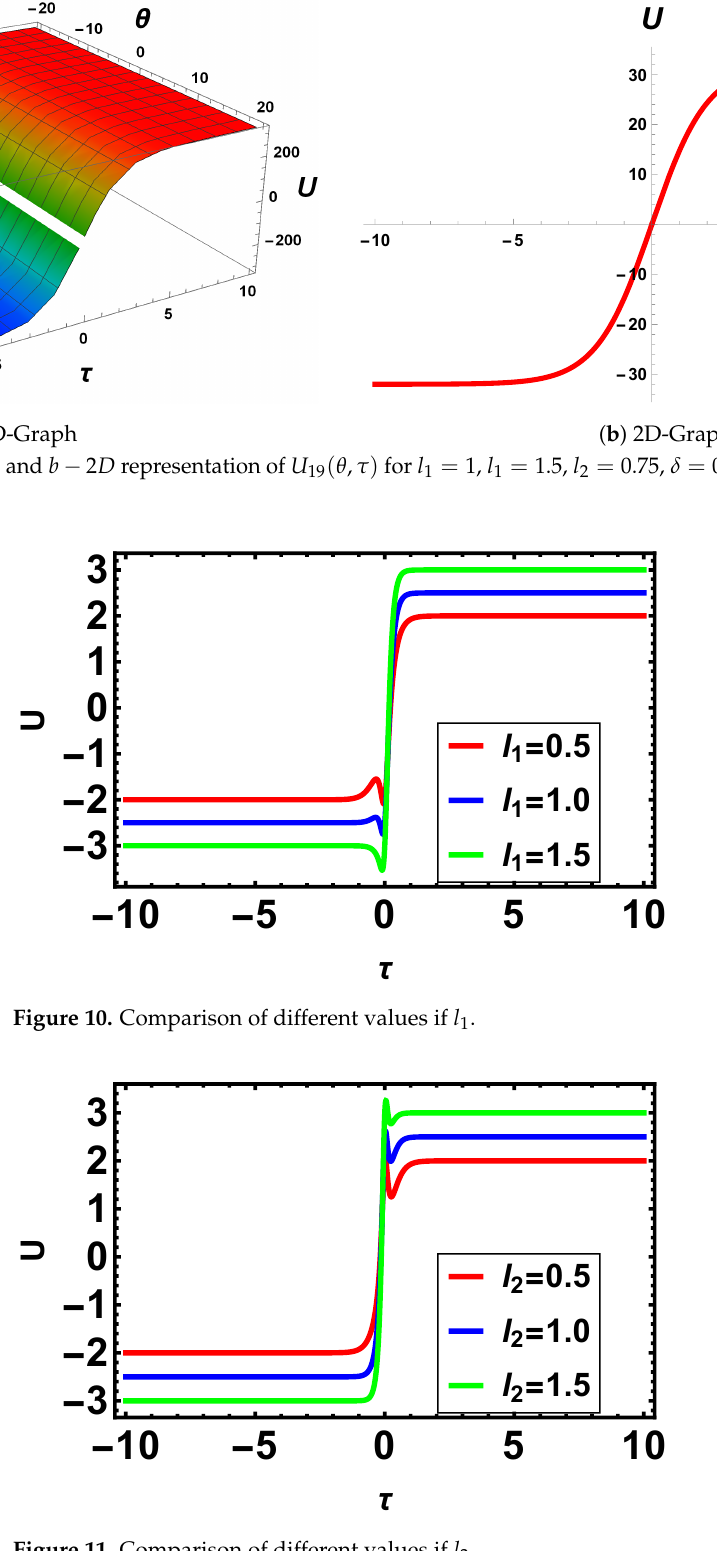
Figure 11. Comparison of different values if l 2